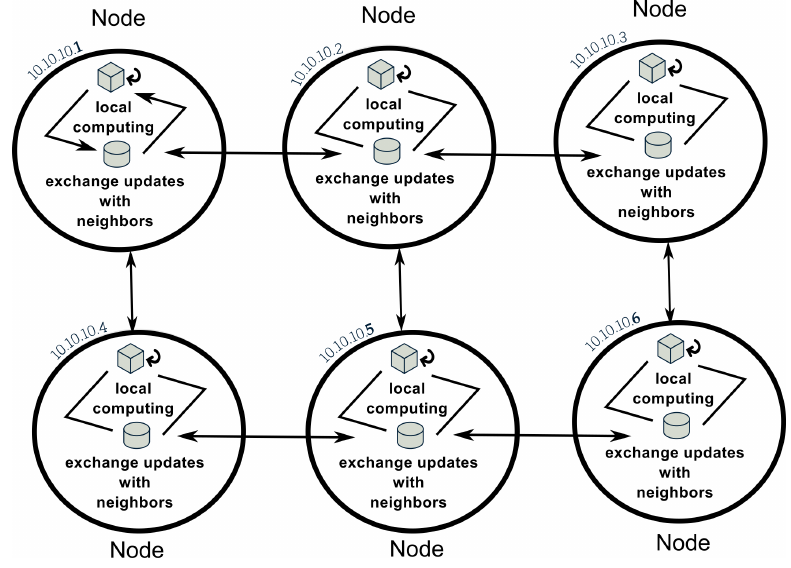
Figure 4. Distributed iterative computing